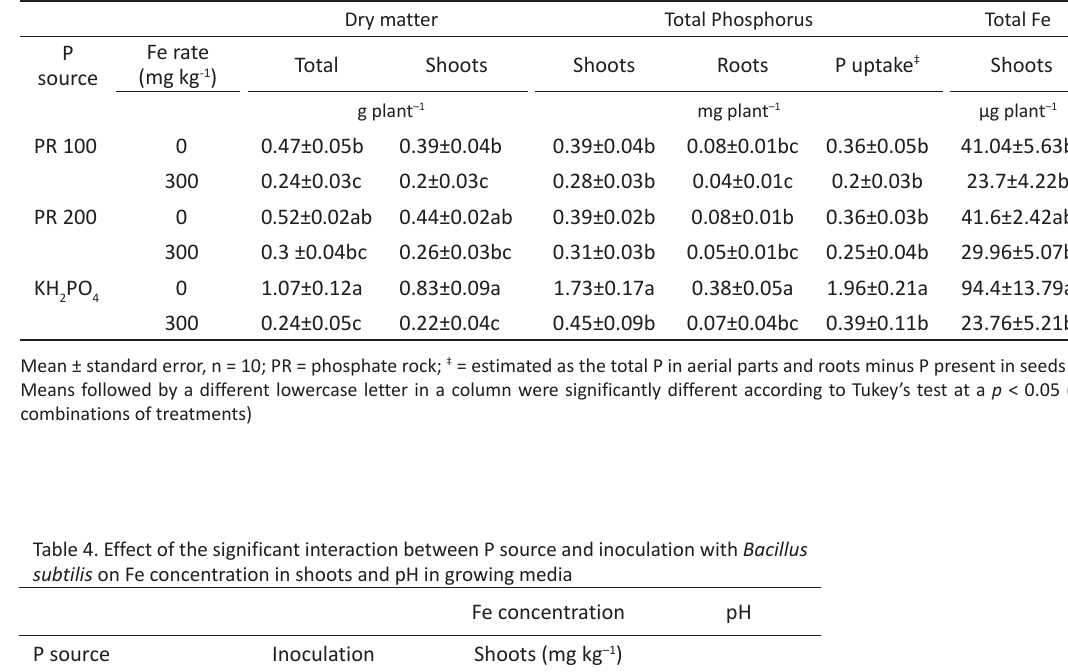
Table 4. Effect of the significant interaction between P source and inoculation with Bacillus subtilis on Fe concentration in shoots and pH in growing media Fe concentration pH P source Inoculation Shoots (mg kg –1 ) B .subtilis 104ab 9.33bc PR 100 + – B.subtilis 106ab